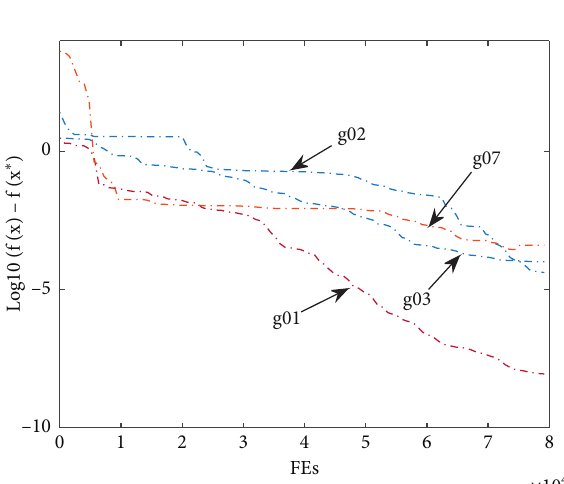
Figure 6: Convergence graph for g01–g03 and g07.